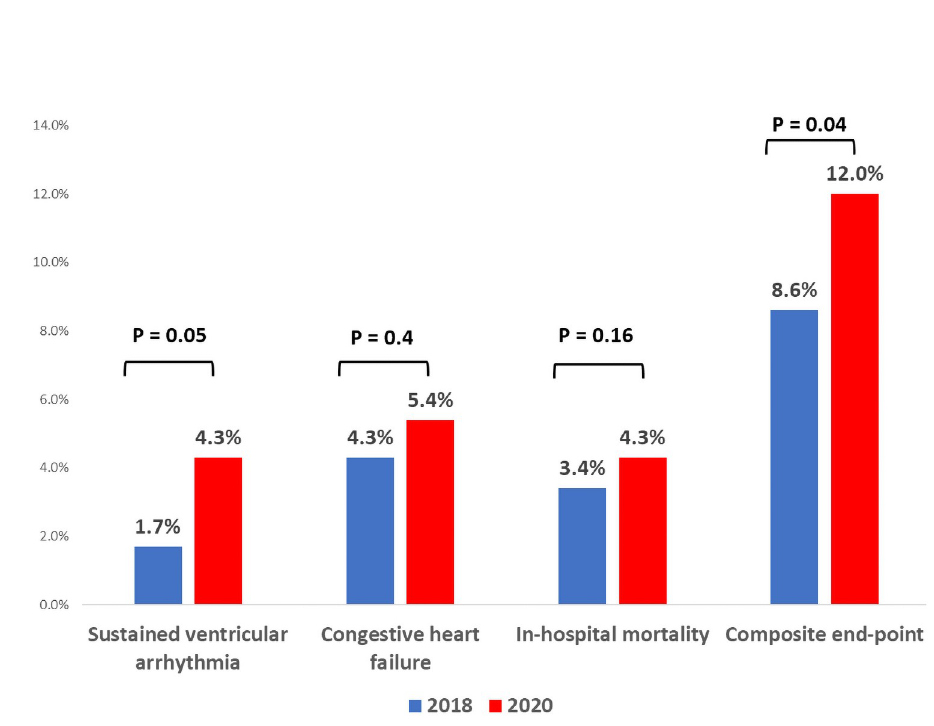
Fig 5. Distribution of primary end-point and its individual components according to the hospitalization period. Red bars represent patients admitted with STEMI during the Covid-19 era and blue bars represent patients admitted with STEMI during the corresponding control period in 2018. � Multivariable logistic regression model further adjusted for elderly patients ( > 65 years), diabetes mellitus, hypertension, dyslipidemia, smoking status, prior coronary artery disease and chronic renal